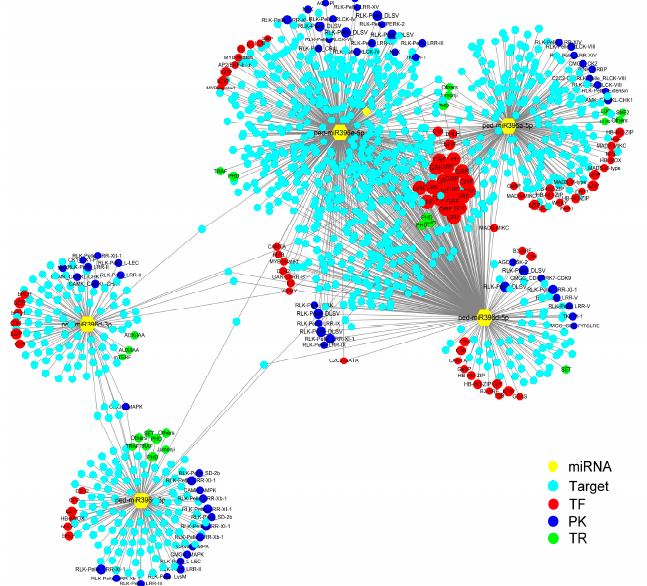
Figure 2. The regulatory network of the five miR396s and their predicted targets using Cytoscape. MiR396s and their target genes are indicated by yellow triangles and blue solid circles, respectively. Their targets encoding PKs, TFs, and TRs are indicated by deep blue, red, and green circles, respec- tively.